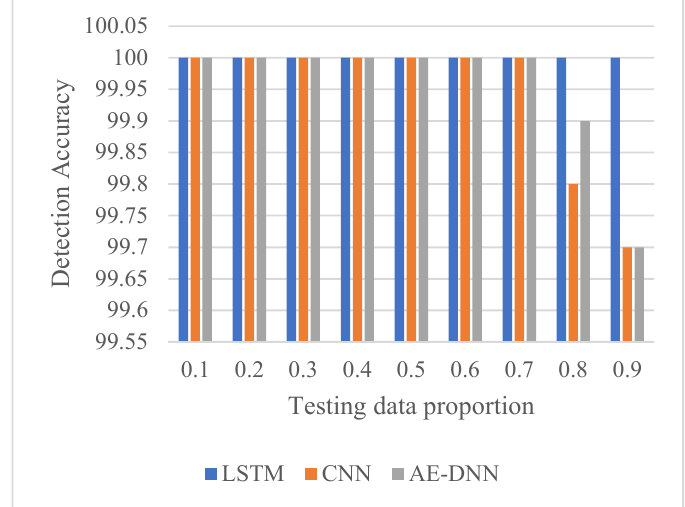
Figure 9. Comparison of detection accuracy.